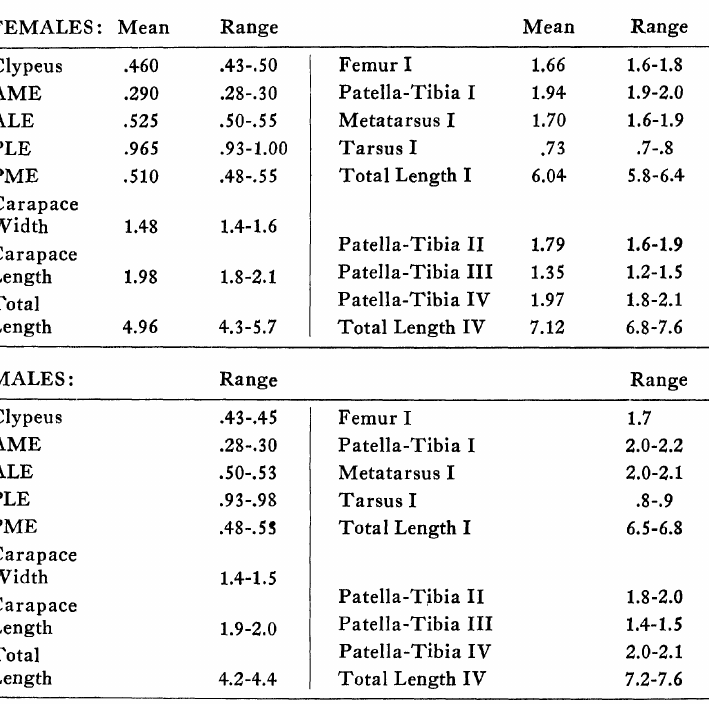
Figs. 47-48. Oxyoles flavus Banks, female from Iquala, Guerrero, 27 Oct. 1947. 47. Internal genitalia. 48. Epigynum. Figs. 49-50. Oxyoles flatus Banks, female from Tonala, Chiapas, Aug. 1909. 49. Internal genitalia. 50. Epigynum. Fig. 51. Oxyopes flatus Banks, epigynum of female from Alamos, Sonora, 7 Aug. 1956. Fig. 52. Oxyopes lingulifer F.O.P.-Cambridge O. fla,us, epigynum of female holotype from Costa Rica. Fig. 53. Oxyopes flavus Banks, epigynum of female from Valles, San Luis Potosi, 19 July 1956. Fig. 54. Oxyopes flavus Banks, epigynum of female syntype from Sierra San Lazaro, Baja